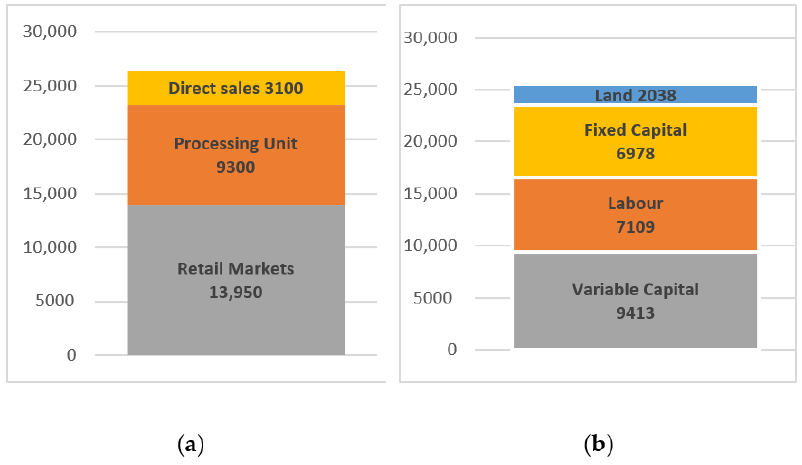
Figure 5. Average annual revenues ( a ) and costs of production ( b ) per hectare (source: own elaboration).